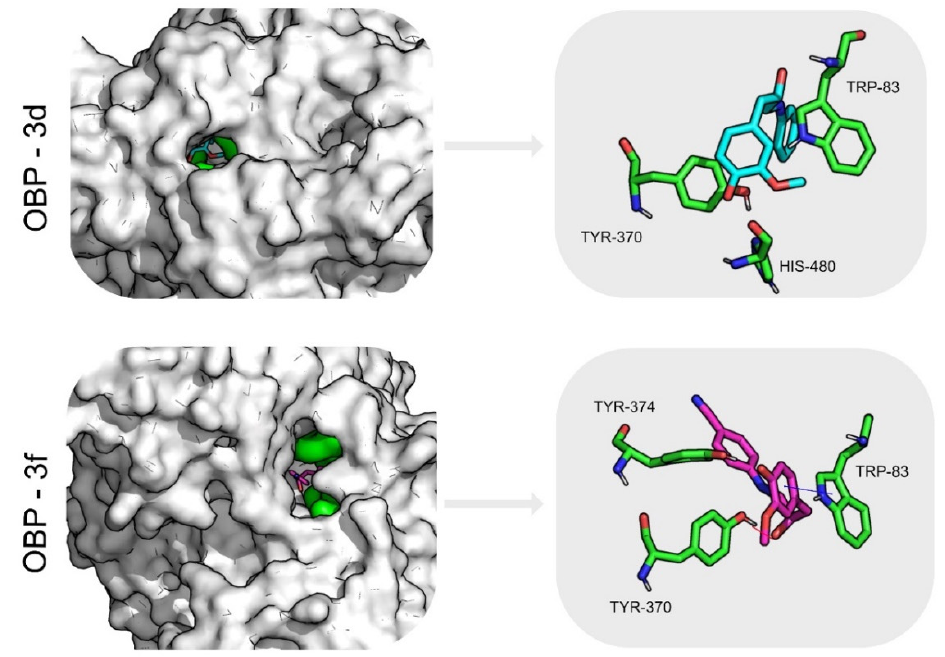
Figure 5. Compound 3d (cyan licorice) and compound 3f (pink licorice) interaction map with OBP1. The most important residues are highlighted in green.